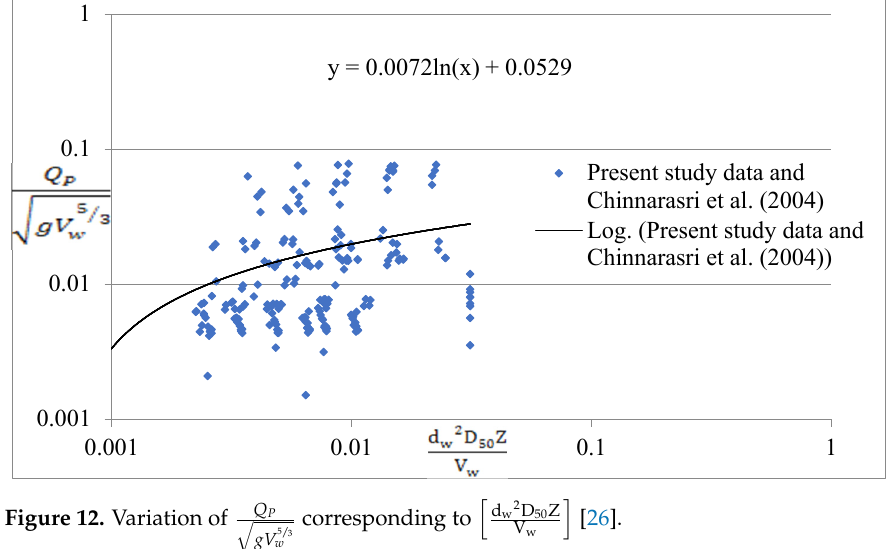
corresponding to gV 5 / 3 w